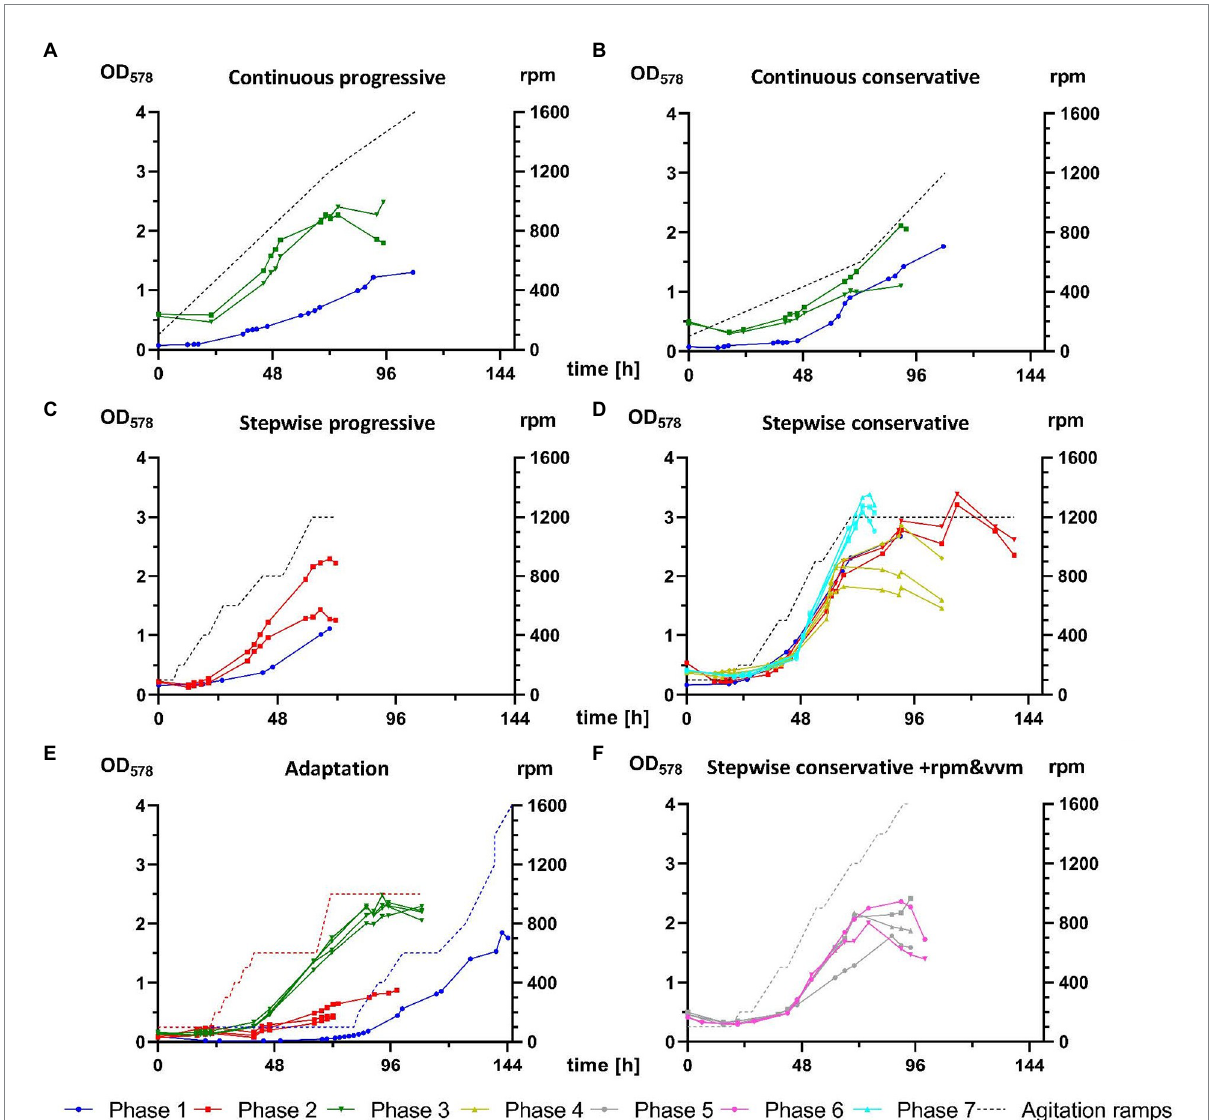
FIGURE 3 Comparison of M . maripaludis growth in 1.5 L reactor cultures. OD 578 (left Y axis) measured over time in h for replicates subjected to the following agitation profiles (rpm on right Y -axis): (A) continuous progressive (Phases 1 and 3), (B) continuous conservative (Phases 1 and 3), (C) stepwise progressive (Phases 1 and 2), (D) stepwise conservative (Phases 1, 2, 4, and 7), (E) growth of reactors cultures from Phases 1–3 subjected to adaptation rounds, (F) optimization of stepwise conservative ramps by increase of agitation and supply of gaseous substrate (+rpm and vvm) or by increase of agitation and supply of gaseous substrate and decrease of OD 578 of inoculum (+rpm and vvm-OD) from Phases 5 and 6, respectively. Further details are presented in Table